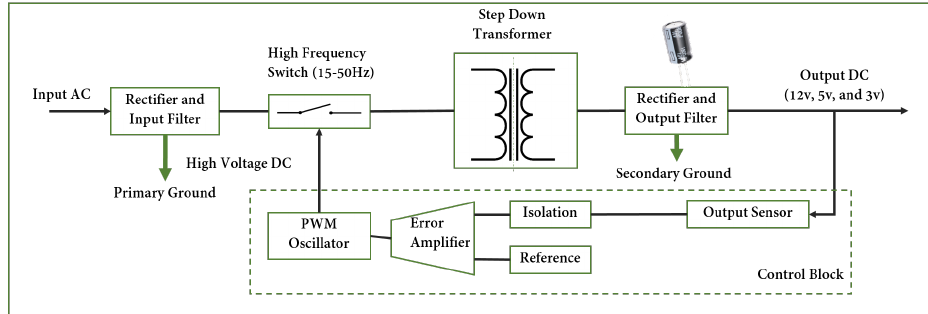
Figure 2. The working principle of SMPS AC-DC converter